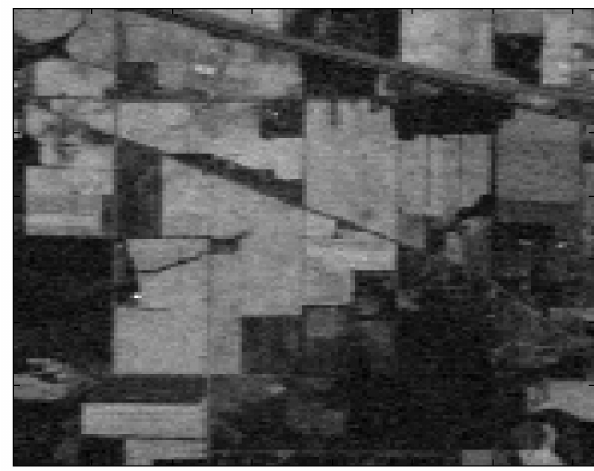
Figure 1. Sample band from the Indian Pines dataset.